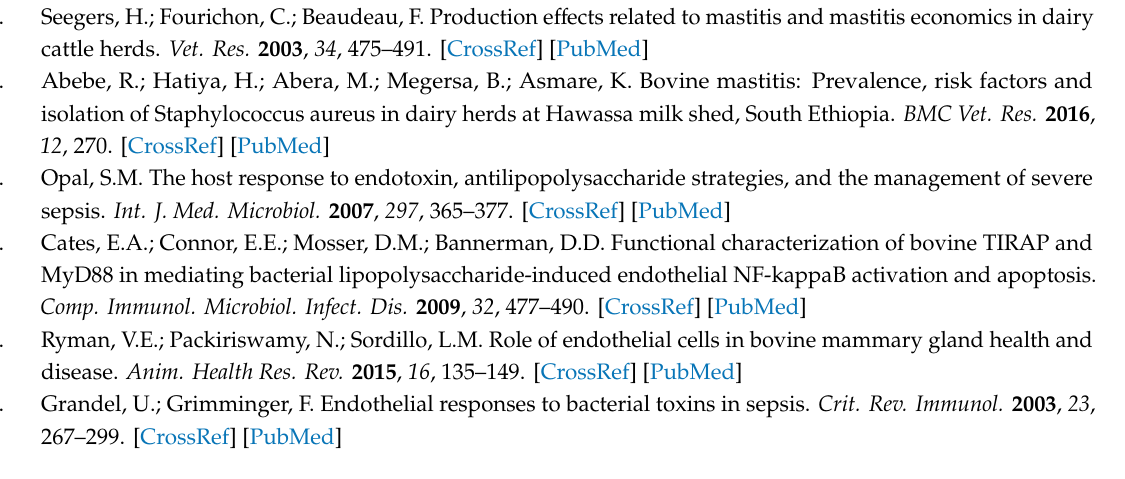
Figure S1: Cytotoxicity of C. nutans extract fractions; Figure S2: Antiapoptotic activity of C. nutans by TUNEL assay; Figure S3 Antiapoptotic activities of C. nutans fractions; Figure S4 HPLC profile of C. nutans fractions; Figures S5–S8 LC-MS / MS data result of C. nutans